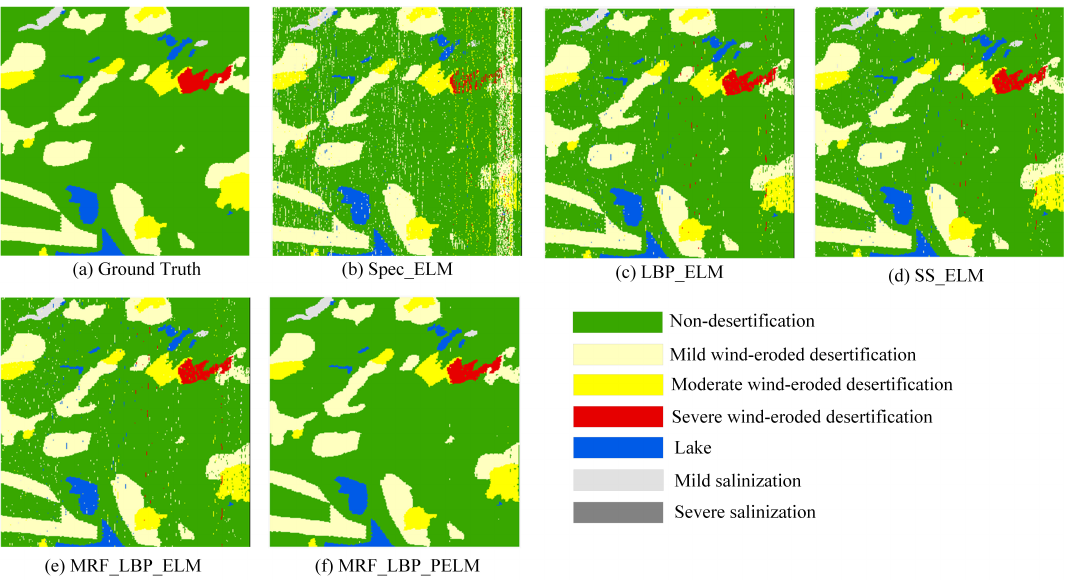
Figure 14. Comparison of visual interpretation results of different methods on complex terrain areas